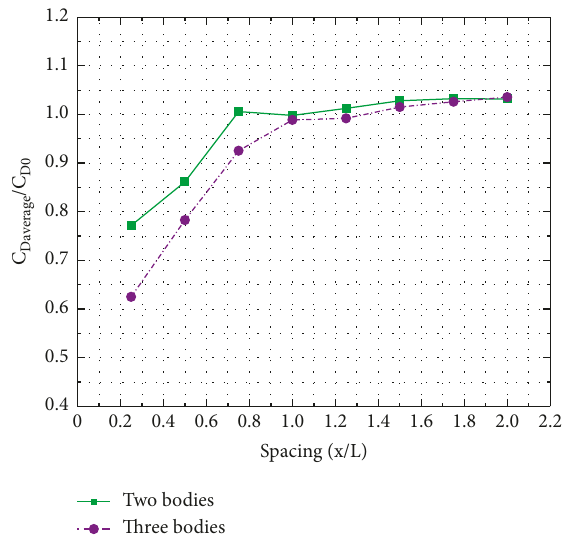
Figure 19: Comparison of the average drag coefficients of two bodies and three